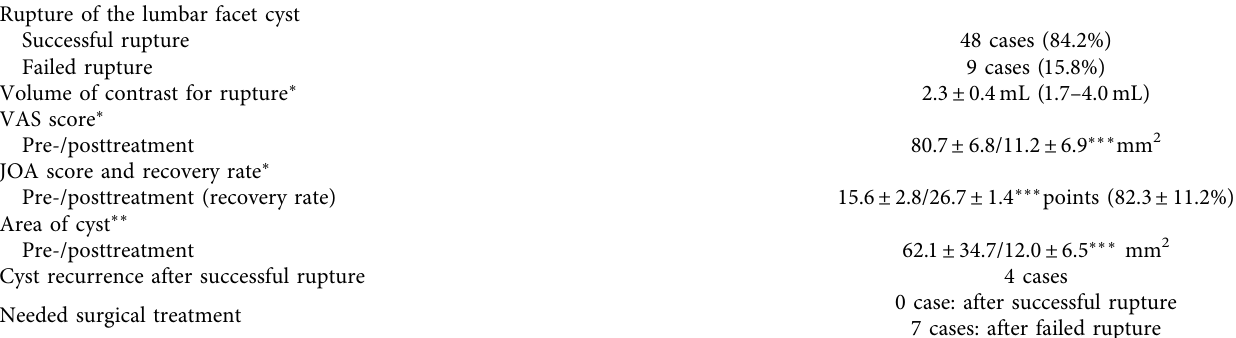
Table 2: Results of percutaneous image-guided rupture of lumbar facet cysts ( N � 57). Rupture of the lumbar facet cyst